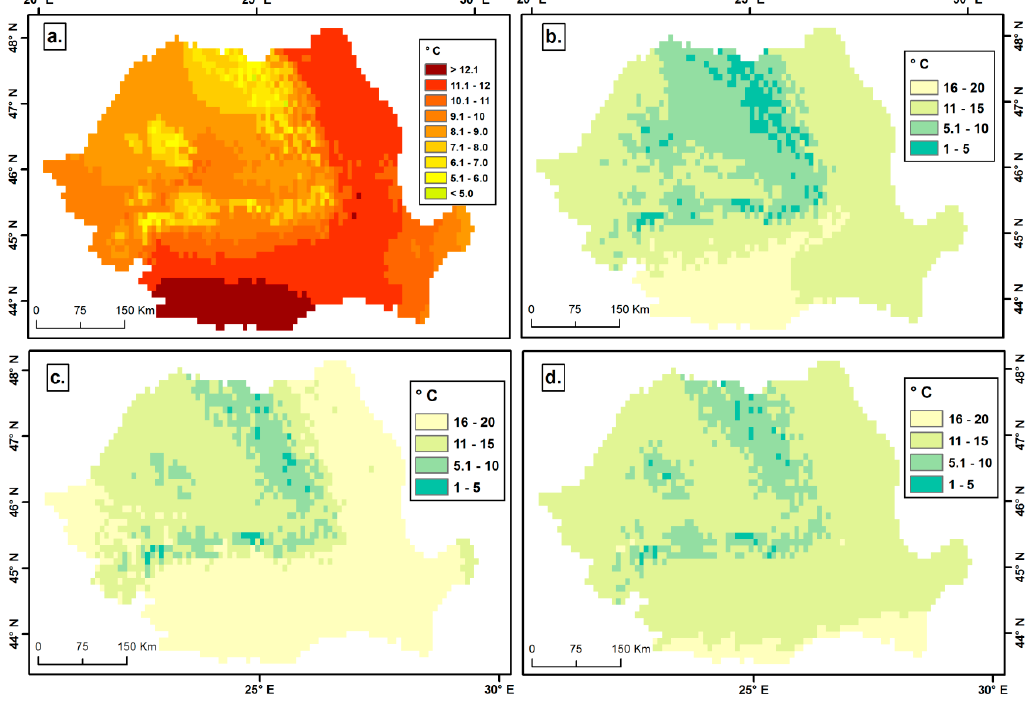
Figure 13. Mean maximum temperature anomaly in Romania in winter ( a ); and mean maximum temperature in: December ( b ); January ( c ); and February ( d ) for B3 WS type based on the ROCADA gridded database.